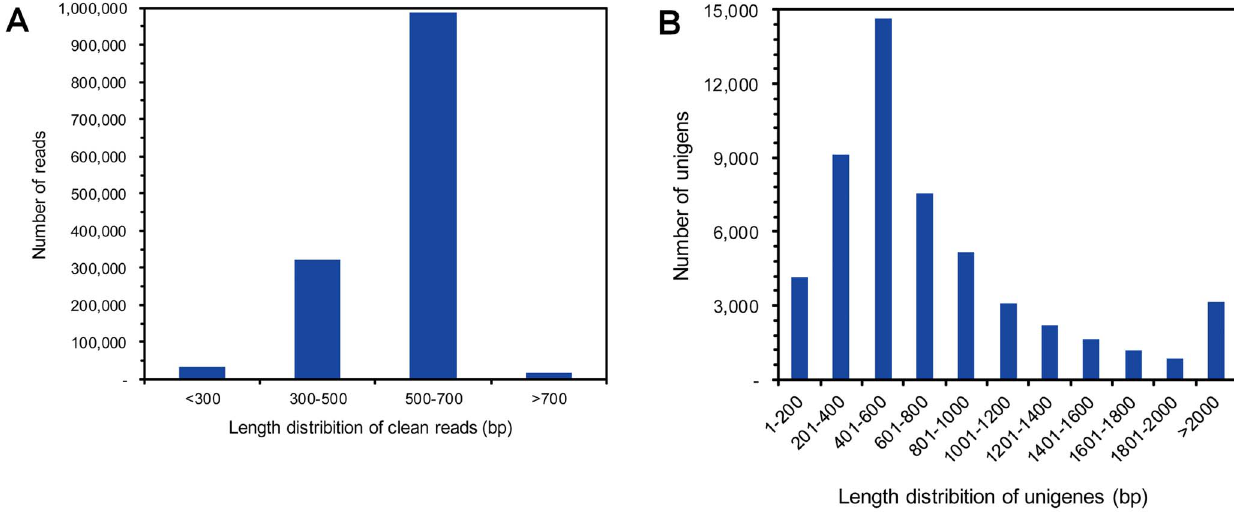
Figure 1. Length distribution of clean reads (A) produced by 454 pyrosequencing and the assembled unigenes (B).